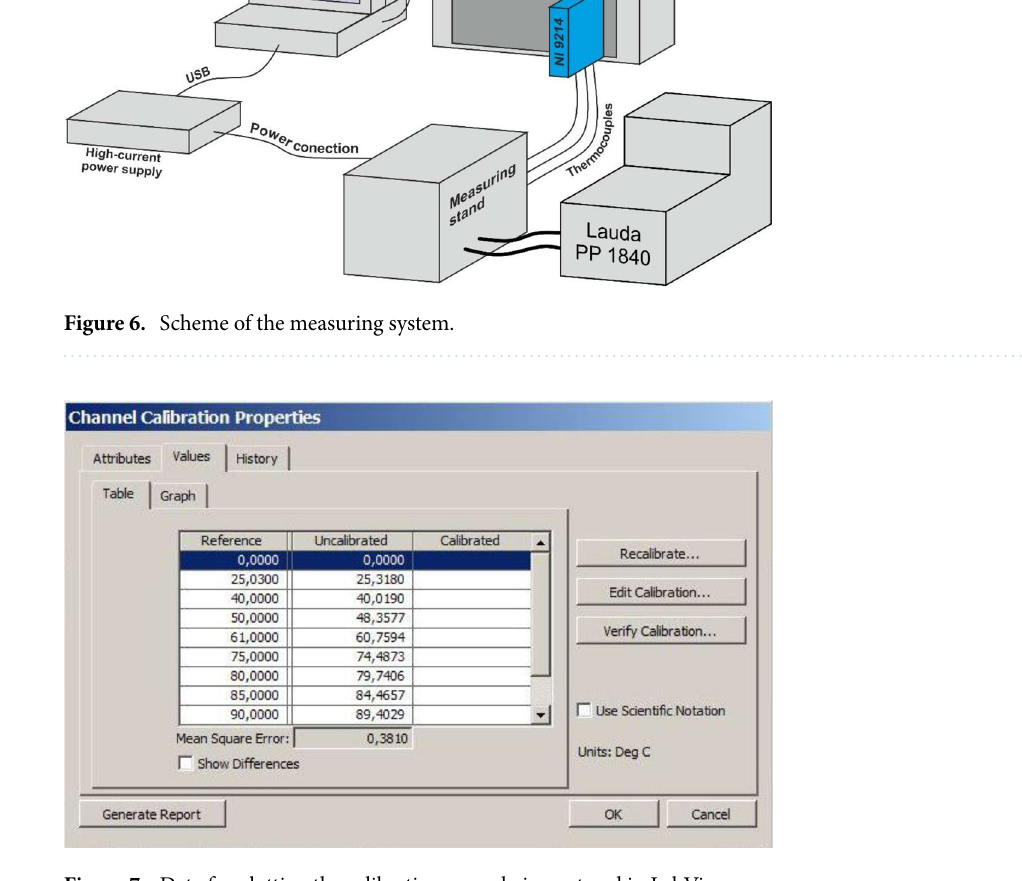
Figure 7. Data for plotting the calibration curve being entered in